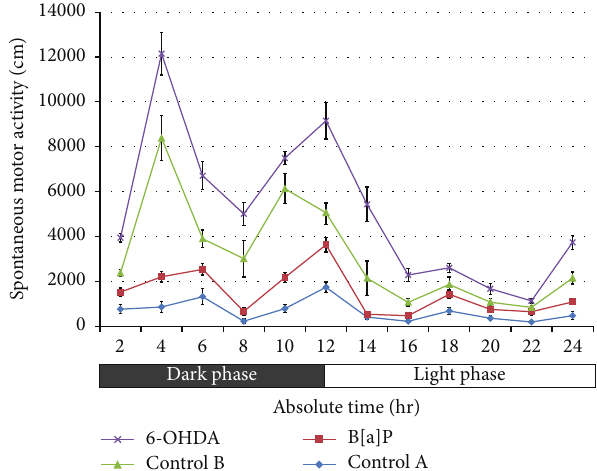
Figure1:Spontaneousmotoractivity(SMA).Graphshowingsignif- icant increase ( 𝑝 < 0.001 ) in SMA after 24 hrs of recording following B[a]P and 6-OHDA administration. The data were represented as mean ± SEM ( 𝑛 = 12